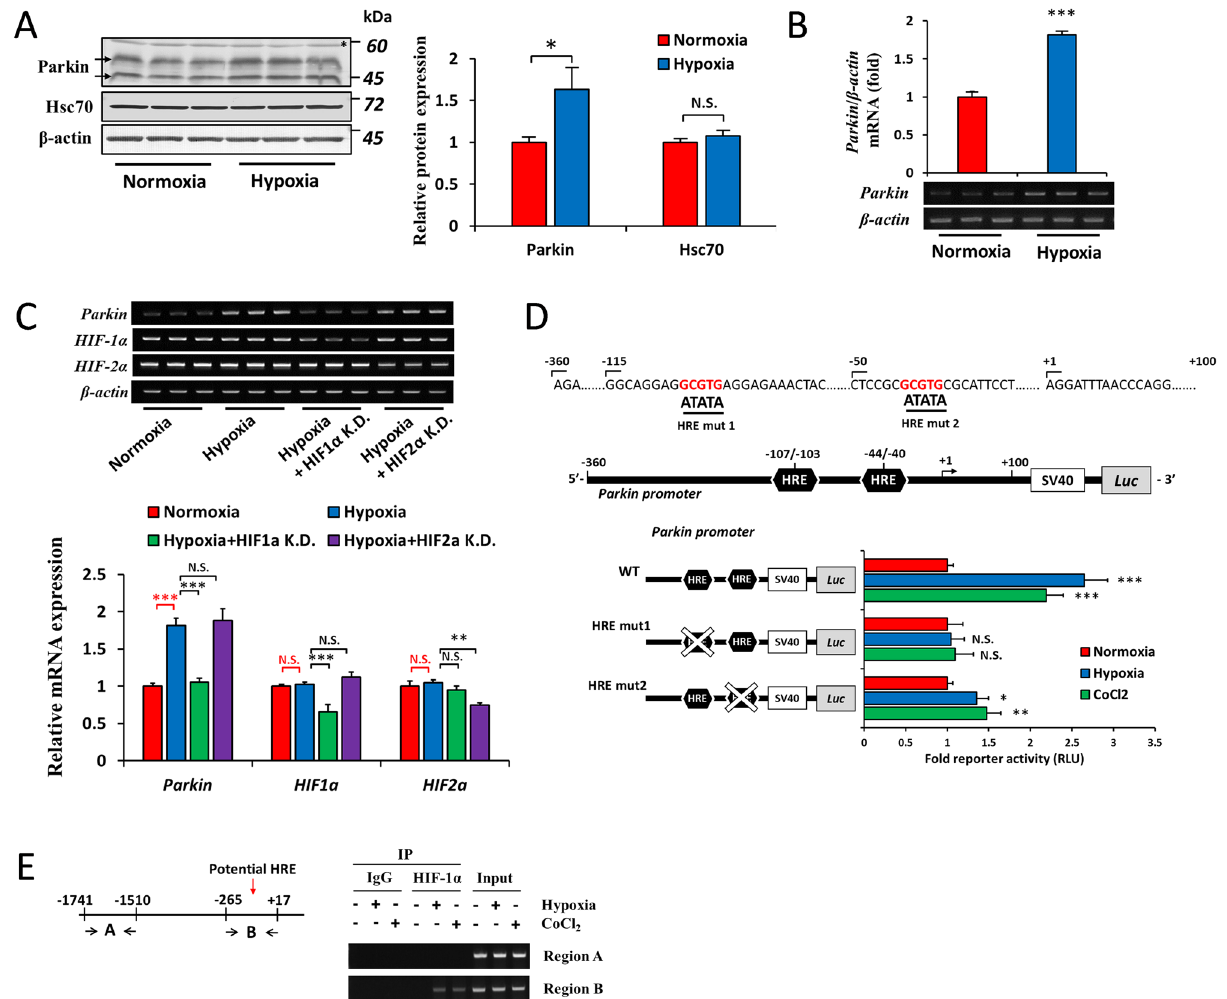
Figure 5. HIFs regulate the expression of Parkin . (A and B) Hep3B cells were cultured under normoxia or hypoxia (O 2 = 1%) for 12 h, and the protein expression of Parkin and Hsc70 ( A ) and the mRNA level of Parkin ( B ) were assessed by immunoblotting and RT-PCR, respectively. ( C ) Hep3B cells were transfected with siRNA- Control, siRNA-HIF-1α (HIF-1α K.D.), or siRNA-HIF-2α (HIF-2α K.D.) and incubated under hypoxia (O 2 = 1%, 12 h). The mRNA abundance of Parkin , HIF-1α , HIF-2α , and β-actin was measured by RT-PCR. ( D ) Wild- type hypoxia response elements (HREs) and their mutated constructs (HRE mut 1 and 2) within the Parkin promoter − 360/ + 100 (upper panel) were inserted into the pGL3 vector. These constructs were co-transfected with pRL-null into Hep3B cells and then cultured under normoxia or hypoxia (O 2 = 1%) or treated with CoCl 2 (100 µM, normoxia) for 12 h. Luciferase activity was then measured. ( E ) Genomic positions of Parkin regions that were selected for the ChIP assay (left panel). Hep3B cells were incubated under normoxia or hypoxia (O 2 = 1%) or treated with CoCl 2 (100 µM, normoxia) for 12 h, and the ChIP assay was performed with the anti-HIF-1α antibody or control rabbit IgG, with input chromatin as the positive control. After reverse cross- linking, DNA was amplified using the indicated primer sets (right panel). Data are the mean ± S.D. of triplicate experiments. N.S. not significant, * p < 0.05, ** p < 0.01, *** p < 0.001 versus the indicated group, calculated with a one-sample t -test with Bonferroni’s correction (for figure A), a one-sample t -test (for figures B ), or a multivariate one-way ANOVA with Tukey’s post-hoc test (for figures C and D were partly involved in the down-regulation of p62 protein expression, whereas reductions in p62 mRNA levels were entirely independent of HIFs. We herein revealed that Nrf2 regulated hypoxia-induced decreases in p62 levels. Nrf2 is considered to regulate the expression of p62 in response to electrophiles, reactive oxygen species, and nitric oxide, and, as a result of the positive feedback loop, directly binds to ARE in the promoter of the p62 gene 18,43 . We also demonstrated that Nrf2 regulated not only the inducible expression of p62 , but also its basal expression, and also down-regulated its expression under hypoxia. Mechanistically, we previously reported that hypoxia induced the phosphorylation of Nrf2 by protein kinase C, thereby inhibiting the Keap1-depend- ent degradation of Nrf2, and simultaneously stabilized E3 ligase Siah2, which subjected Nrf2 to proteasomal degradation 37 . The prevention of hypoxia-induced decreases in Nrf2 by its overexpression or the knockdown of Siah2 restored reductions in p62 levels. We proved that Nrf2 activity on the previously identified ARE located at